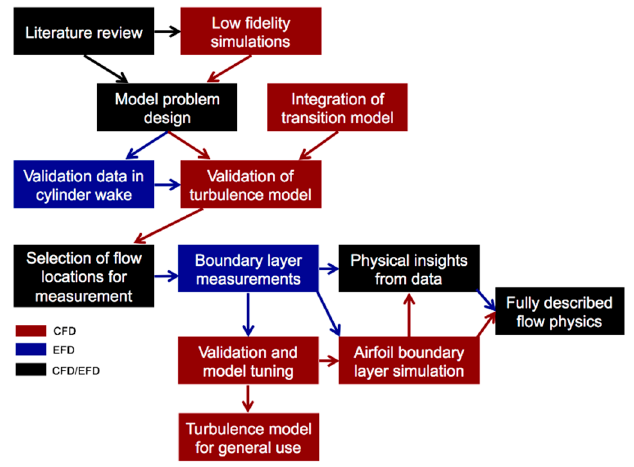
Figure 2. Overview of experimental and numerical procedure used in the research. Experimental efforts in blue, numerical efforts in red and joint contributions in black.